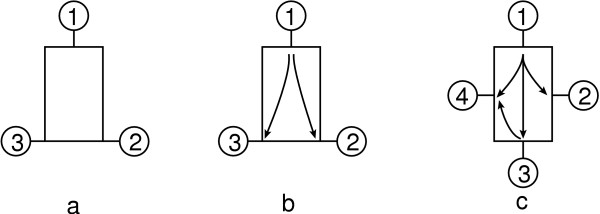
Interaction motifs. Generic examples of scaffold proteins with 3 or 4 docking sites. (a) A scaffold protein with 3 distinct docking sites which do not interact. (b) Another pattern of domain interactions for the same scaffold protein. Here binding domain 1 controls the other two domains. (c) A scaffold protein with 4 docking sites and a more complex pattern of domain interactions. Each pattern of domain interactions can be translated into special kinetic properties (like exemplified in Figure 2).